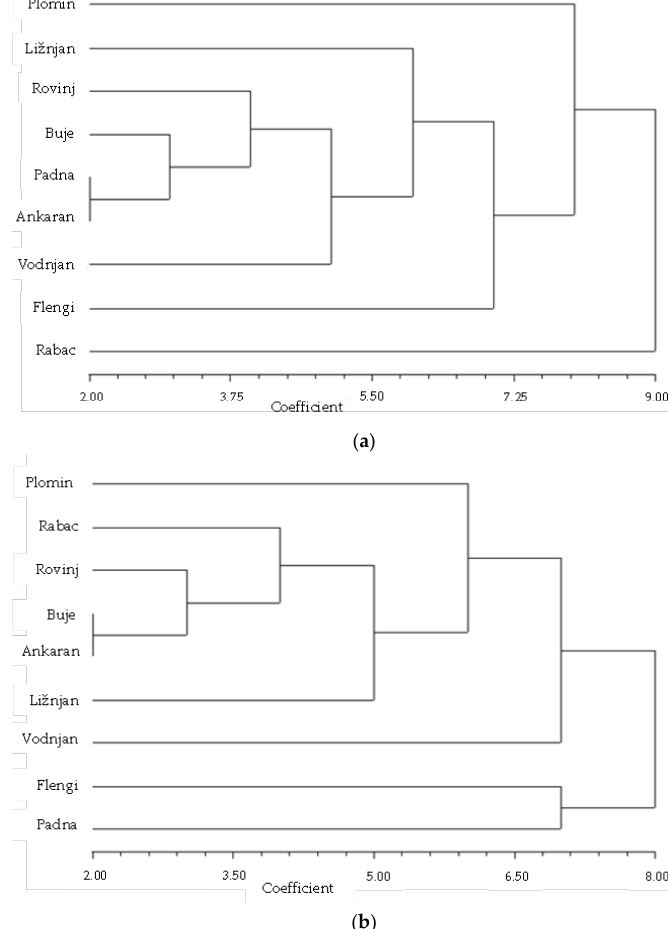
Figure 1. Phenograms of fennel populations reconstructed by using Cavalli–Sforza and Edward’s chord distances [43] and neighbor-joining [45] applied on ( a ) chemical data and ( b ) genetic data. See Section 3.5 for details.